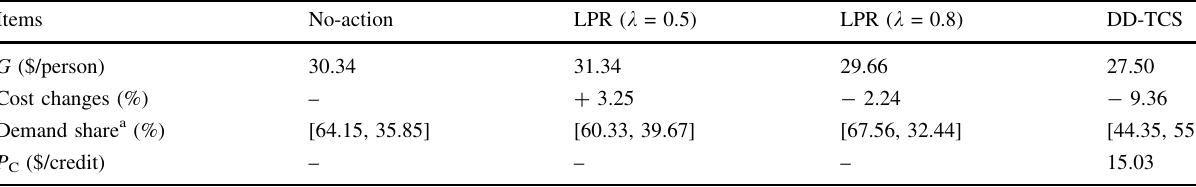
Table 2 System performance metrics under scenarios without transaction